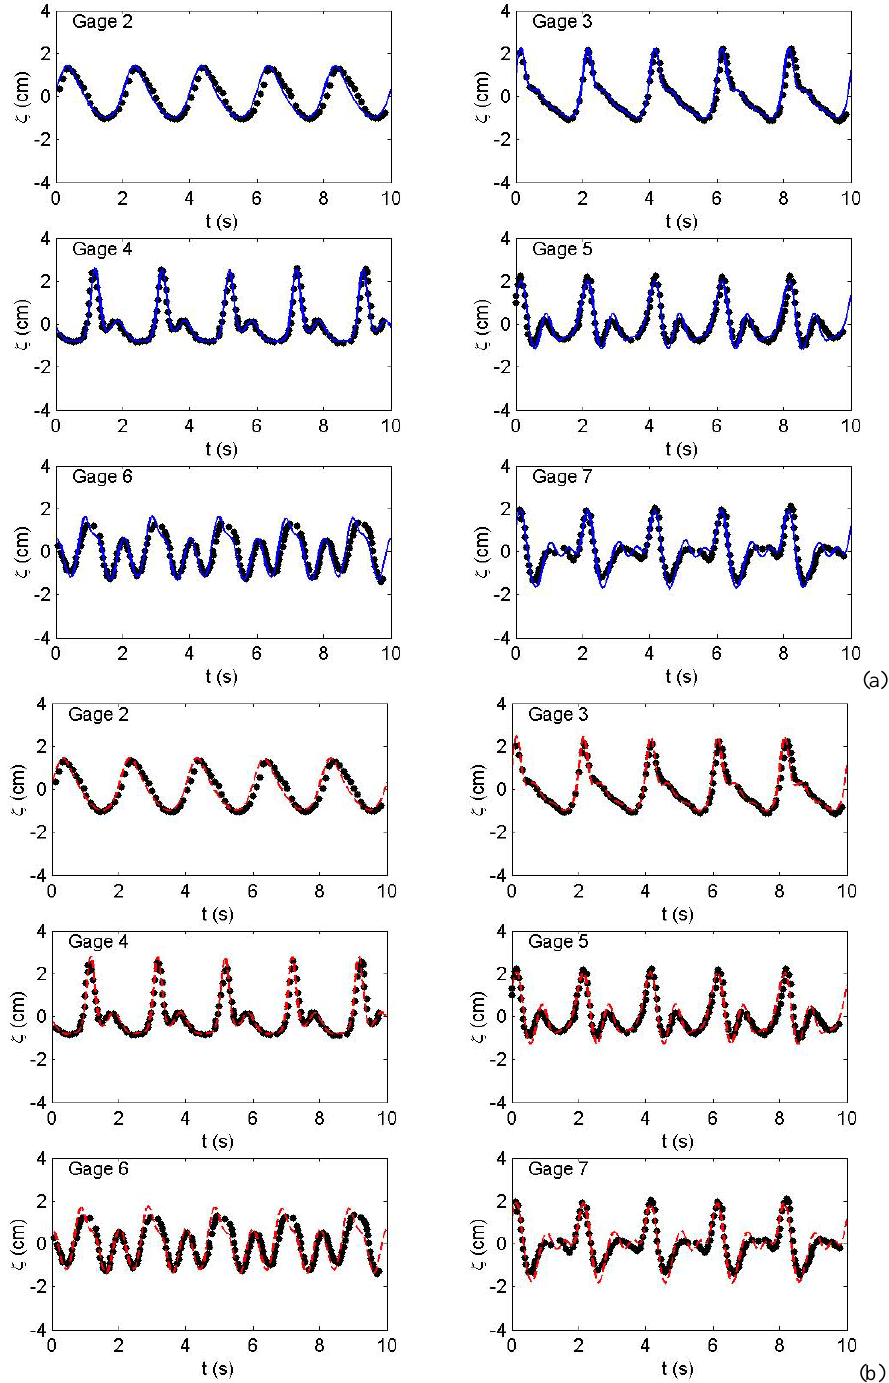
Fig. 7. Time series of water surface elevations in Beji and Battjies’ (1994) experiment: FB (—), GB (- -) and measurements ( (cid:5) ).